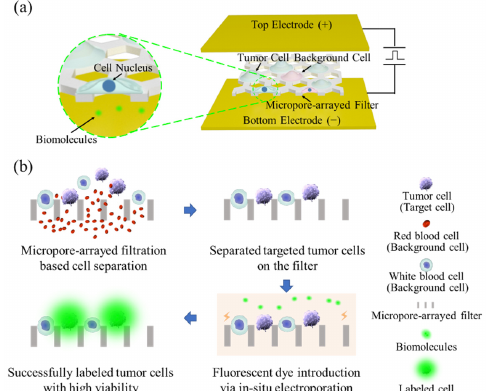
Figure 1. A schematic representation ( a ) and workflow overview ( b ) of the in situ electroporation system on a PERFECT filter.